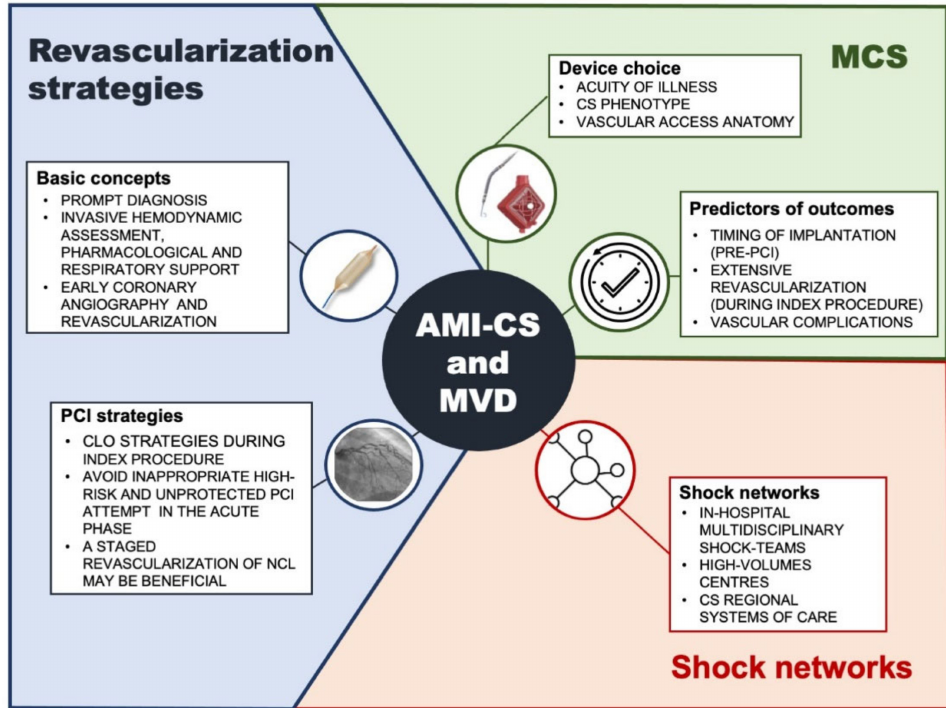
Figure 1. Current best practice for infarct-related cardiogenic shock patients with multivessel coronary artery disease: optimal revascularization strategies, mechanical cardiac support implantation, and shock teams and medical care system networks implementation. CS: cardiogenic shock; MCS: